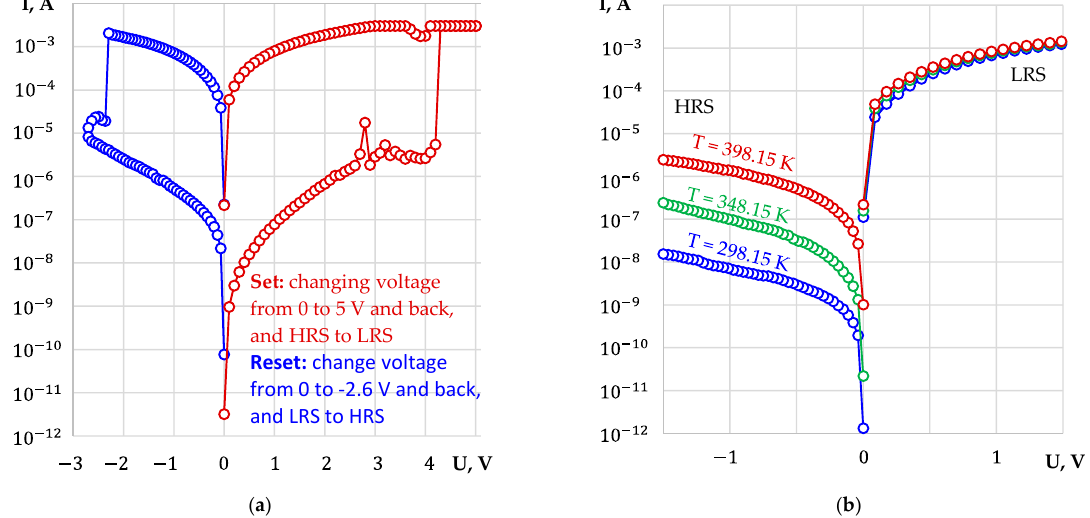
Figure 3. VACs of memristors: ( a ) VAC of one of the switching cycles at room temperature; ( b ) VACs at three temperatures for HRS and LRS.